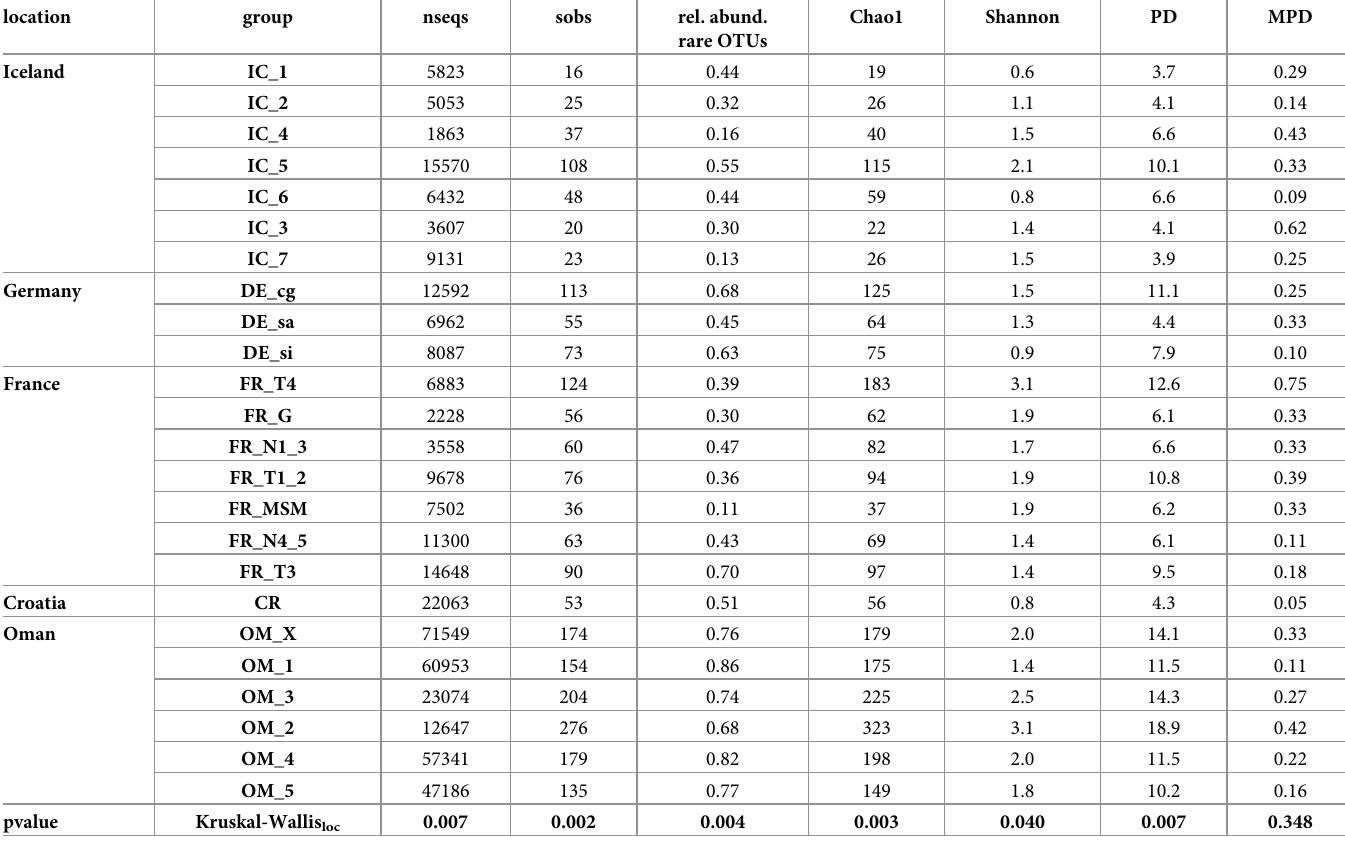
Table 2. OTU- and phylogeny-based alpha diversity.